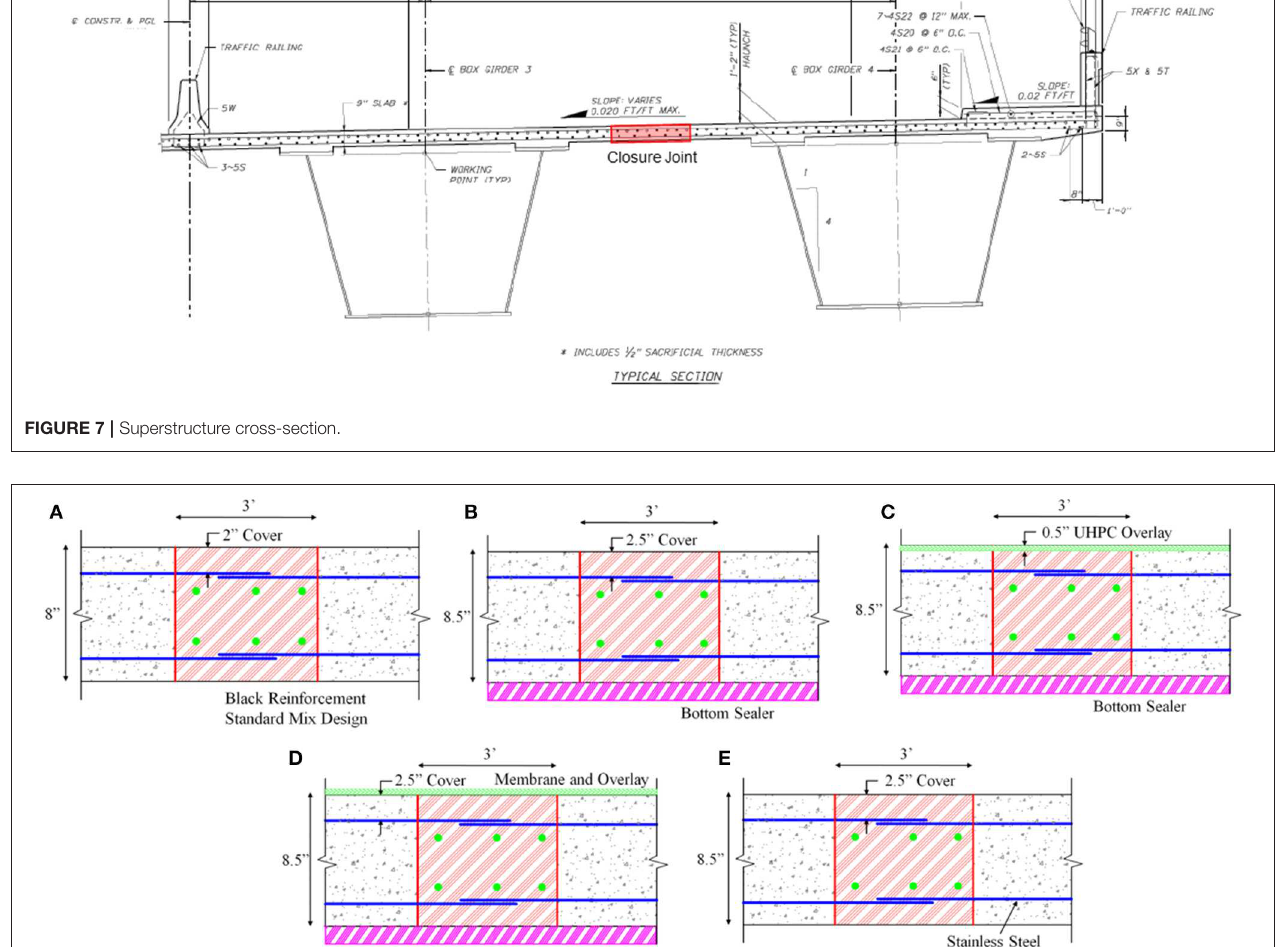
FIGURE 8 | Closure joint Alternative 1, using NSC with straight bars (A) strength design, (B) Option 1, (C) Option 2, (D) Option 3, and (E) Option 4.